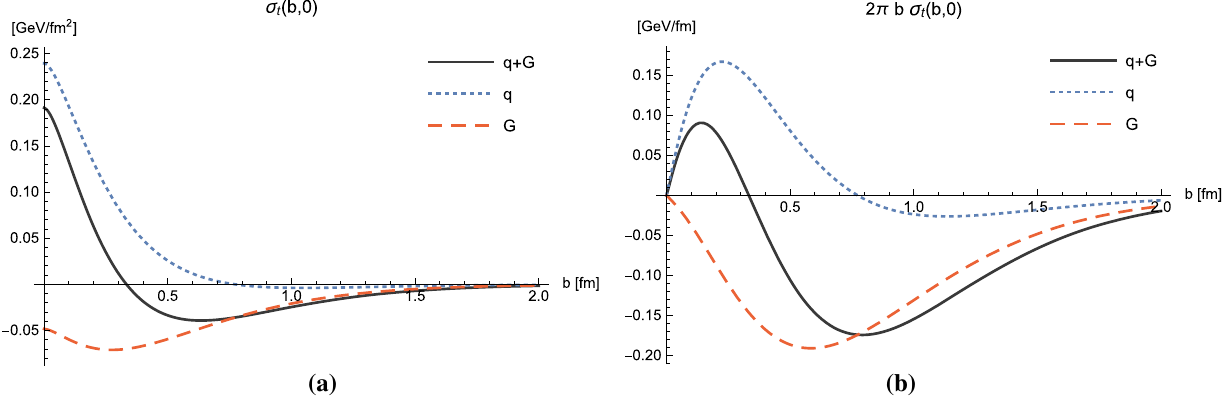
Fig. 13 Plots of the two-dimensional tangential pressure, a σ t ( b , 0 ) and b 2 π b σ t ( b , 0 ) , using the multipole model (11) with parameters given in Table 1, see Eq. (58) or (63) for the definition in terms of GFFs